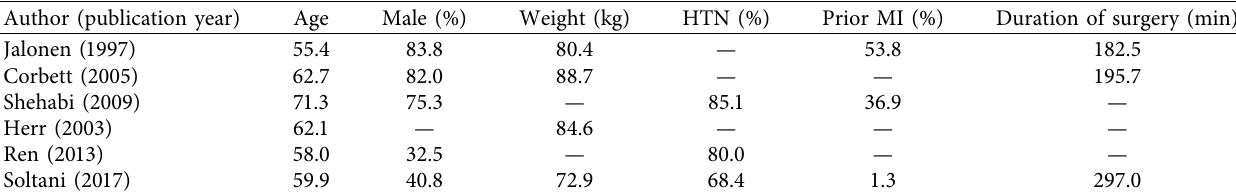
Table 2: Patient characteristics of included randomized controlled trials.